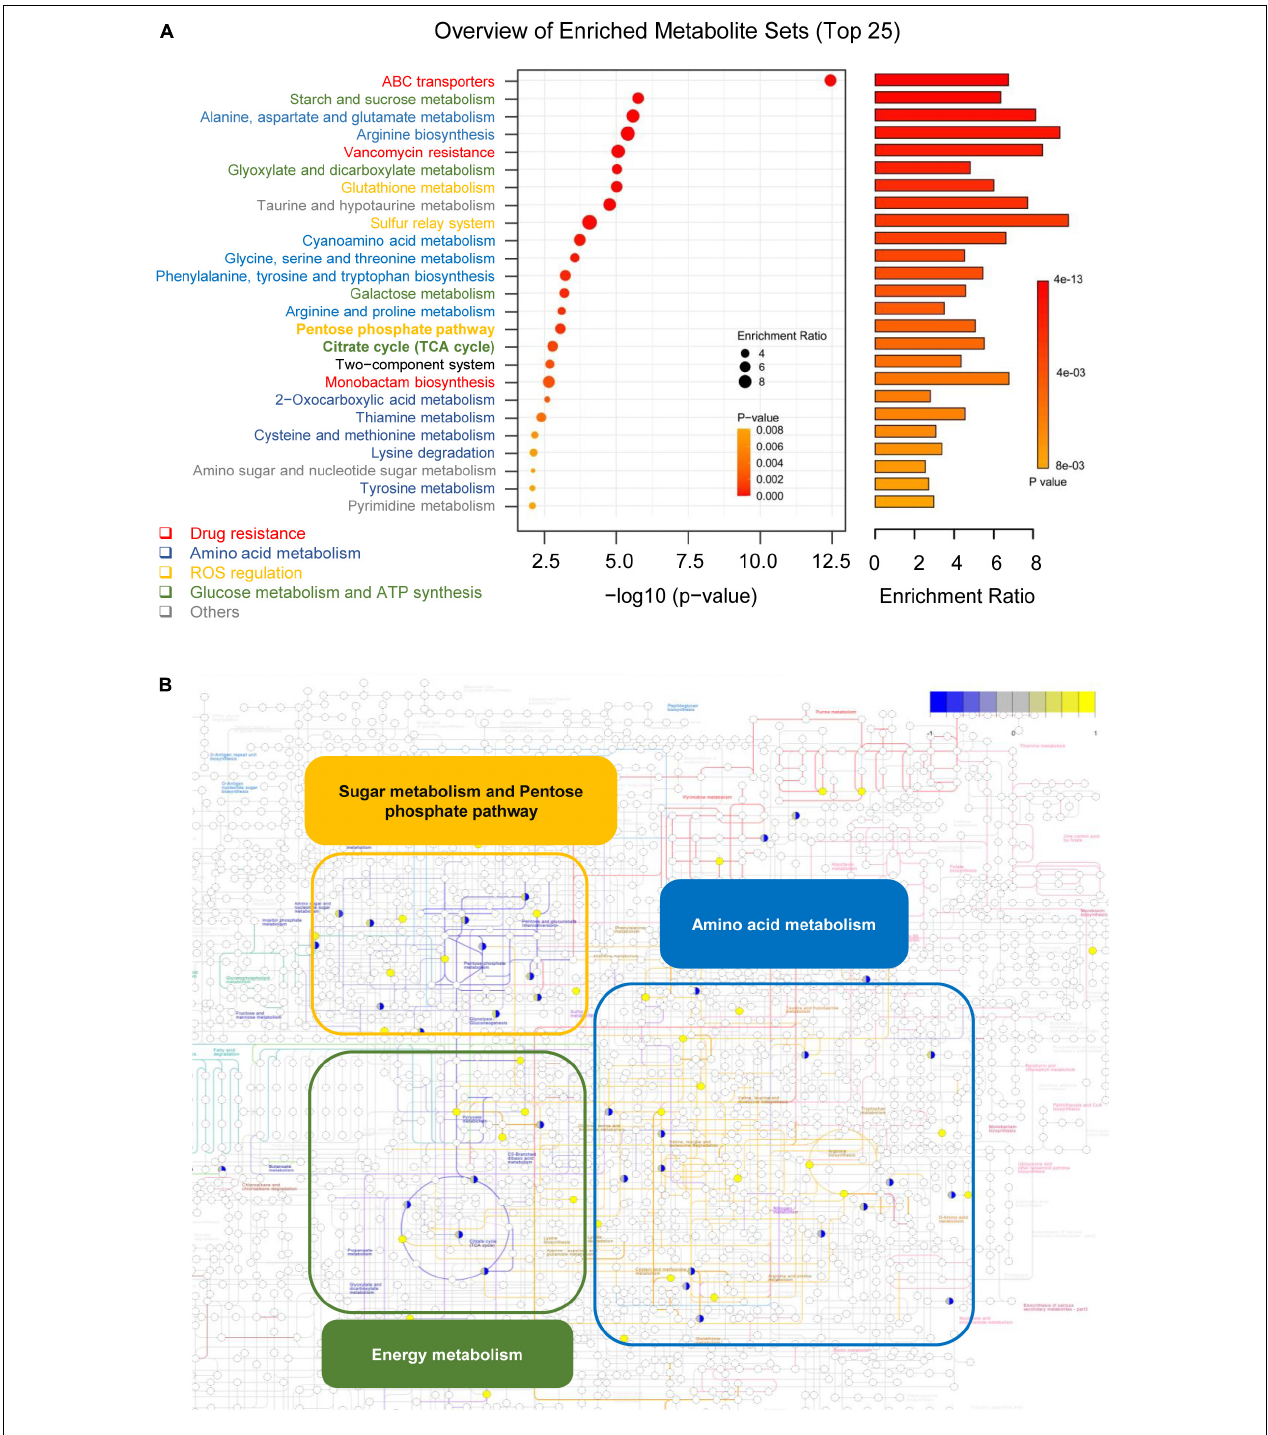
FIGURE 5 | MCA mainly affected the metabolic flux of the TCA cycle, amino acid metabolism, and pentose phosphate pathway in MRSE. (A) Putative signaling pathways affected by MCA were analyzed by enrichment analysis. The enrichment analysis was performed by MetaboAnalyst 2.0 software (http://www.metaboanalyst.ca/) with identified differential metabolites and a reference dataset extracted from KEGG (organism: Ser), and the top 25 pathways were extracted for visualization. The pathways belonged to drug resistance, amino acid metabolism, ROS regulation, glucose metabolism, ATP synthesis, and others are colored red, dark blue, orange, grass green, and gray, respectively. (B) Overview of differential metabolites involved in pathways. The differential metabolites were mapped to the overview of the metabolic pathways (ser: 01100 in KEGG database). The up- and downregulated metabolites are colored yellow and blue,